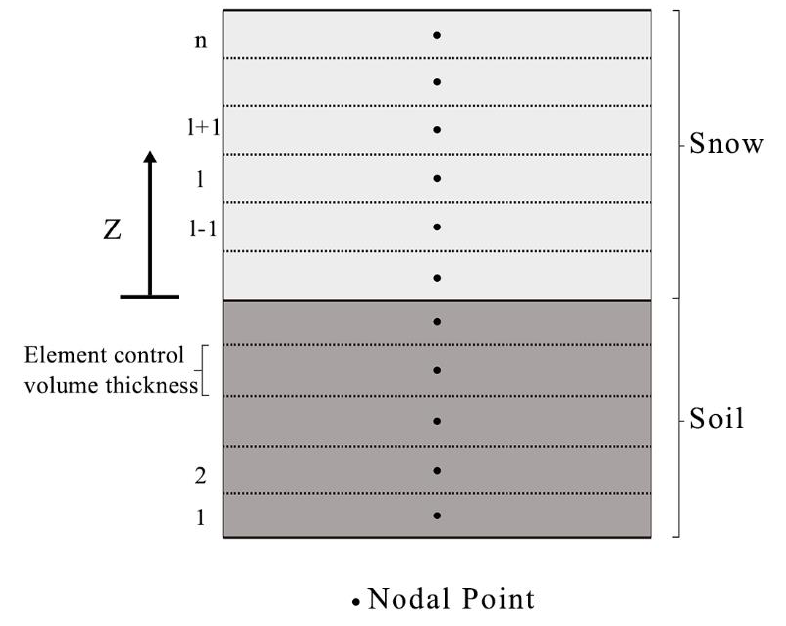
Figure 2. The spatial scheme of the SNTHERM model. Snow and soil are both porous media, the unfrozen water coexists in equilibrium with ice at temperatures below 0 ◦ C. In the SNTHERM code, mass liquid water fraction ( f l [kg · m − 3 /kg · m − 3 ]) within a given medium is a single-valued function of temperature and has a freezing curve characteristic of the snow–soil properties in SNTHERM. Thus, the semi-empirical function is introduced for each node in SNTHERM for f l [33]: